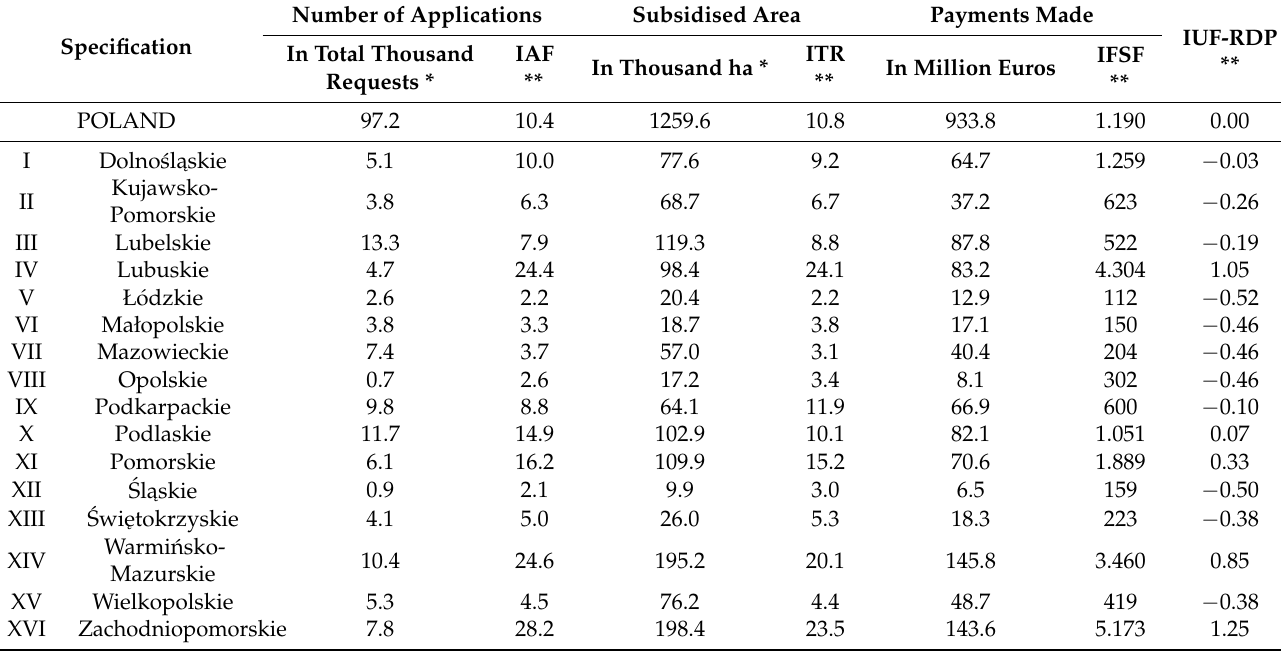
Table 2. Proenvironmental instruments of the Rural Development Program (RDP) 2014–2020 in Poland—together agri- environment-climate (AECM) and organic farming (OFS) measures—selected elements. Source: own elaboration on